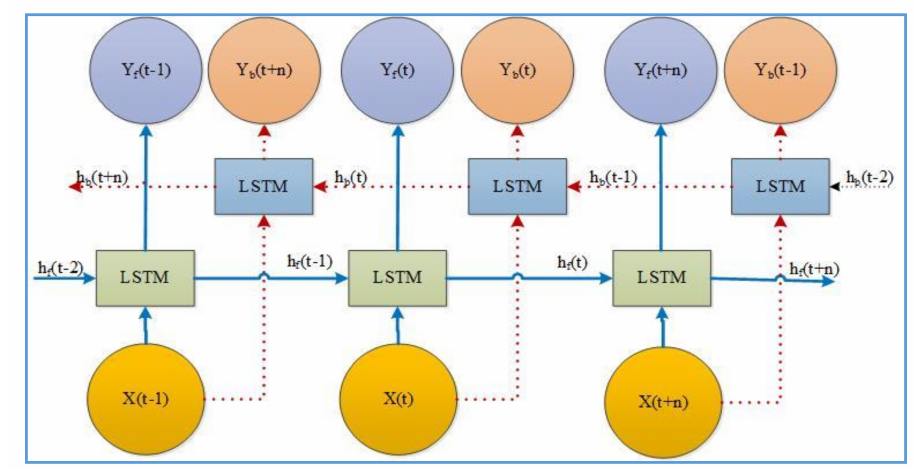
Figure 4. Bi-directional LSTM